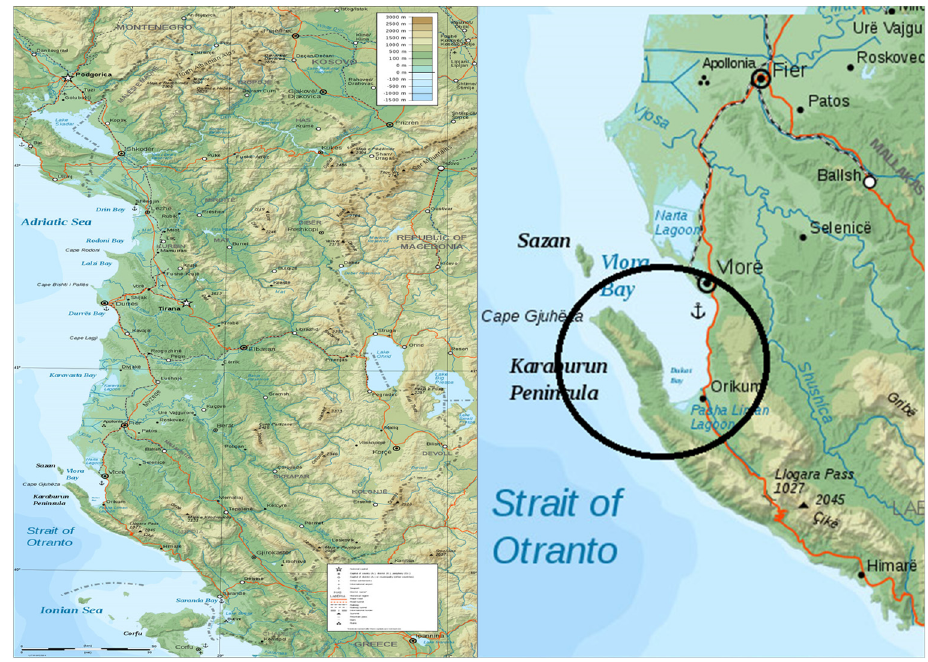
Figure 1. Fishing sampling zone: Vlore, Karaburun (40.35417272574143, 19.438298354632305).